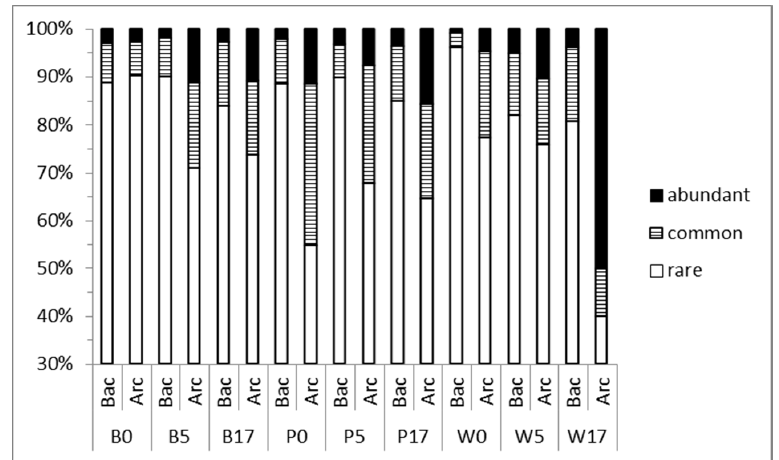
Figure 4. Relative abundance of abundant (>1%), common ( ≥ 0.1% to <1%) and rare (<0.1%) Bacterial (Bac) and Brchaeal (Arc) OTUs in the three different sites at day 0, day 5-exponential growth, day 17-stationary phase. B: Banyuls, P: Pagasitikos, W: Woods Hole.